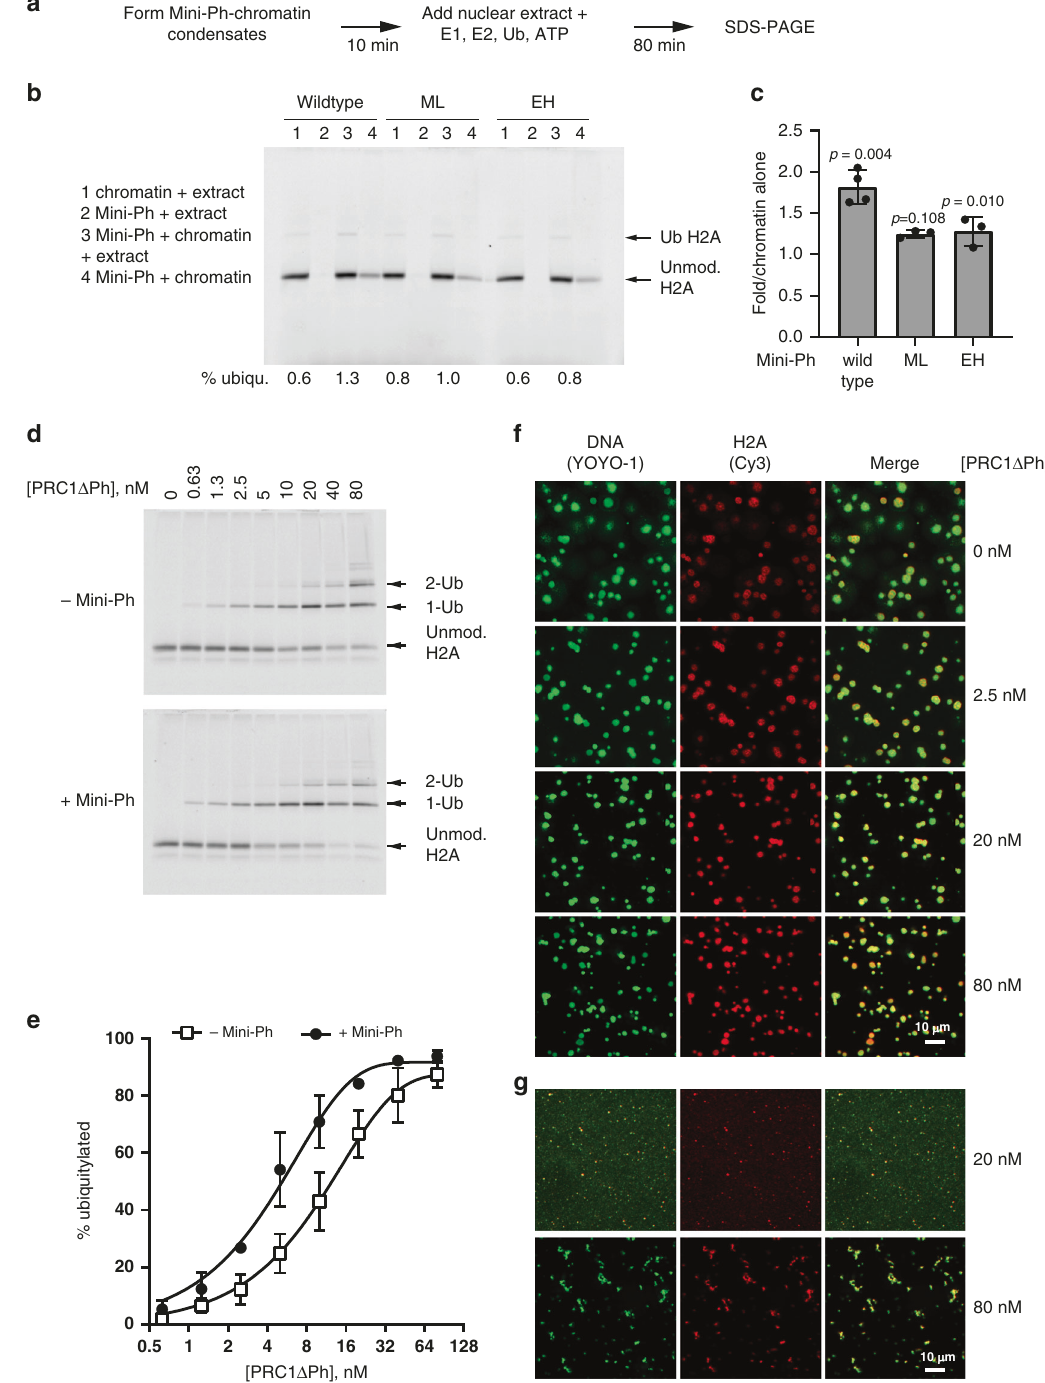
Fig. 6 Mini-Ph condensates facilitate histone ubiquitylation by PRC1. a Scheme for carrying out ubiquitylation assays in nuclear extracts. b Representative SDS-PAGE of Cy3-labeled H2A showing ubiquitylation of chromatin in nuclear extracts in the presence or absence of Mini-Ph (wild type), Mini-Ph-ML, or Mini-Ph EH. Note that the condensates formed in buffer (reaction 4) were poorly recovered in this experiment. c Quanti fi cation of three independent ubiquitylation assays. Bars are mean ±SEM. p Values are for one-sample t test comparing values to the expected value of 1. d Representative SDS-PAGE of Cy3-labeled H2A showing ubiquitylation reaction with PRC1 Δ Ph and chromatin in the presence or absence of Mini-Ph. e Quanti fi cation of ubiquitylation reactions, n = 3. Points are the mean± SEM and data were fi t with an exponential function. f Microscopy of Mini-Ph-chromatin condensates at the end of fully reconstituted in vitro ubiquitylation reactions. g Fibrous condensates are formed by high concentrations of PRC1 Δ Ph in the absence of Mini-Ph; at lower concentrations, no structures are visible. Imaging was conducted for all three independent ubiquitylation experiments and the results were similar. See also Supplementary Figs. 16 and